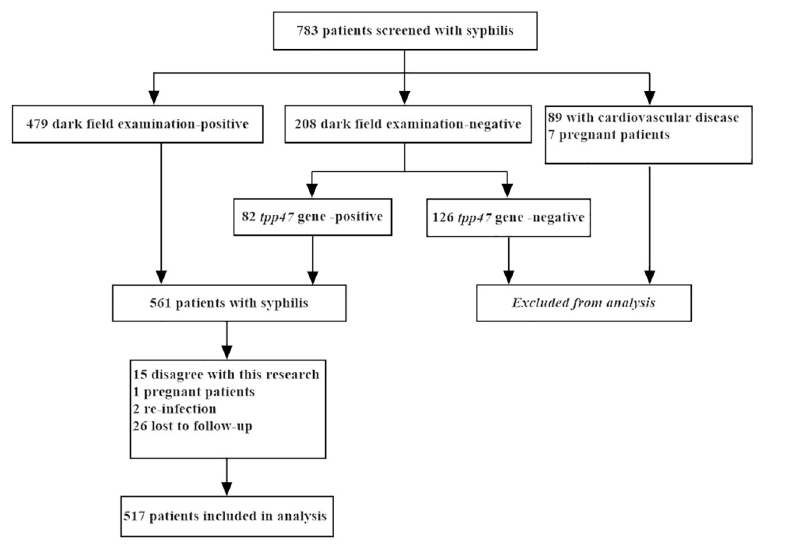
Fig 1. Patients selection flowchart.